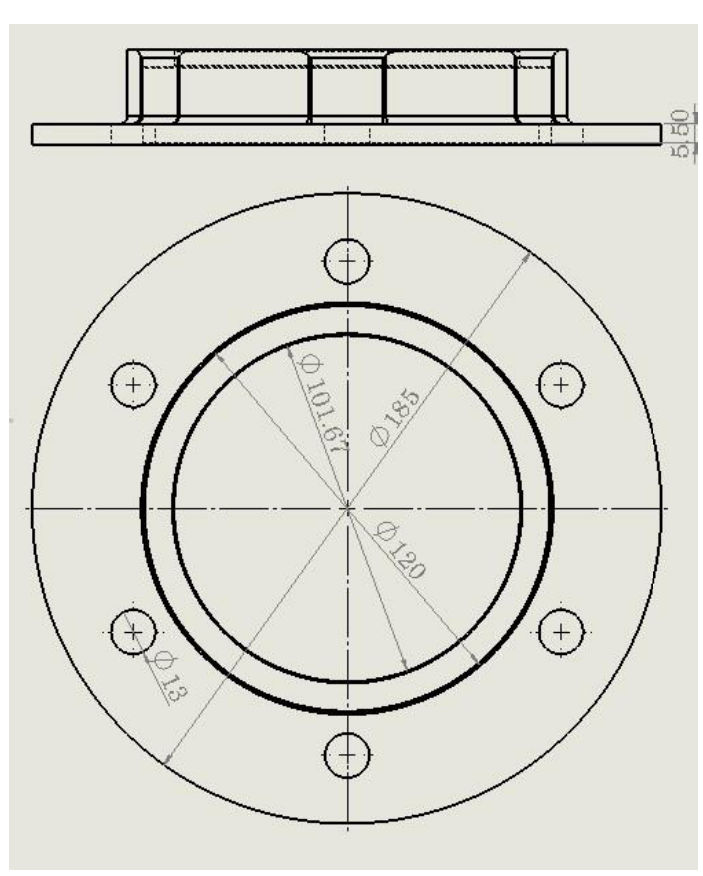
Figure A1. Bearing housing dimensions.